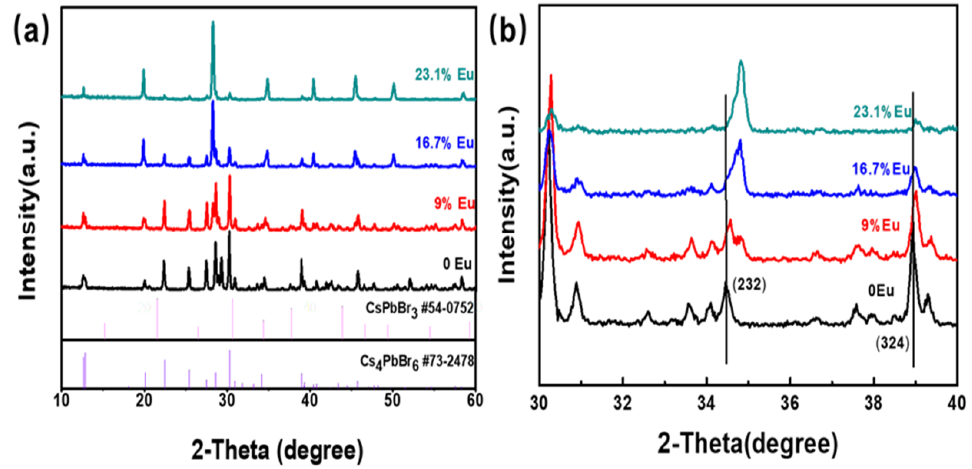
Figure 1. ( a ) XRD patterns and ( b ) magnified XRD patterns of CsPbBr 3 /Cs 4 PbBr 6 and CsP- bBr 3 /Cs 4 PbBr 6 :Eu 3+ with different Eu 3+ doping concentrations.